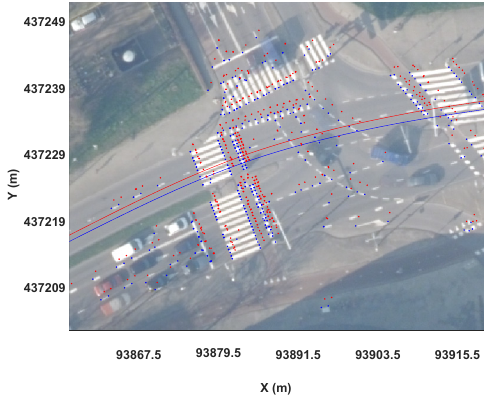
Figure 2: Example of 3D A2A tie points (blue dots) and A2P tie points (red dots) along with the Kalman filtering result (red curve) and trajectory after the adjustment with our method (blue curve).